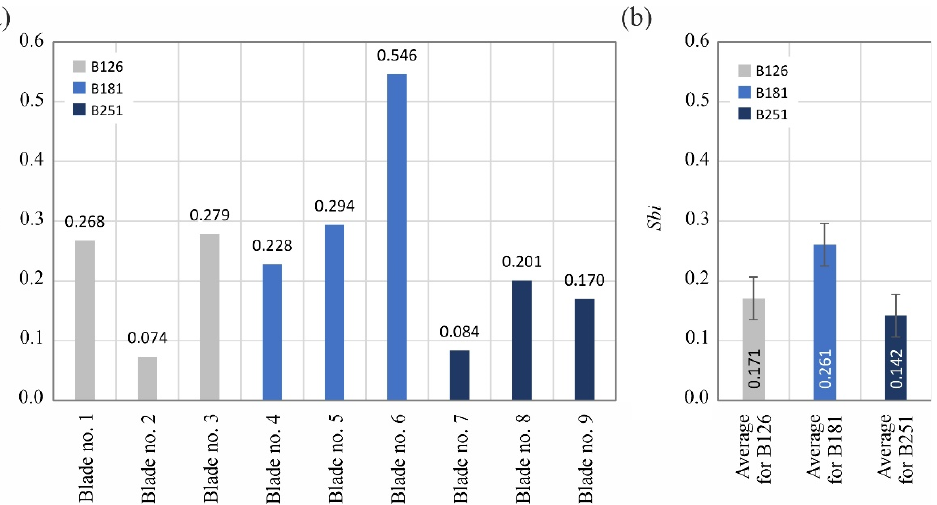
Figure 17. Changes in the developed interfacial area ratio Sdr : ( a ) results for nine blades selected for surface texture measurements; ( b ) average values determined by the size of the cBN abrasive grain of the grinding wheel used (error bars represent the standard error equal to the standard deviation σ divided by the square root of the total number of samples).